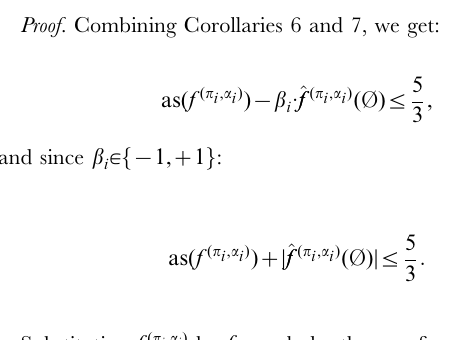
Figure 1. Bounds on the average sensitivity. The dotted-area corresponds to the possible values for the average sensitivity of a NCF, the lined area to BFs with k ~ 5 input